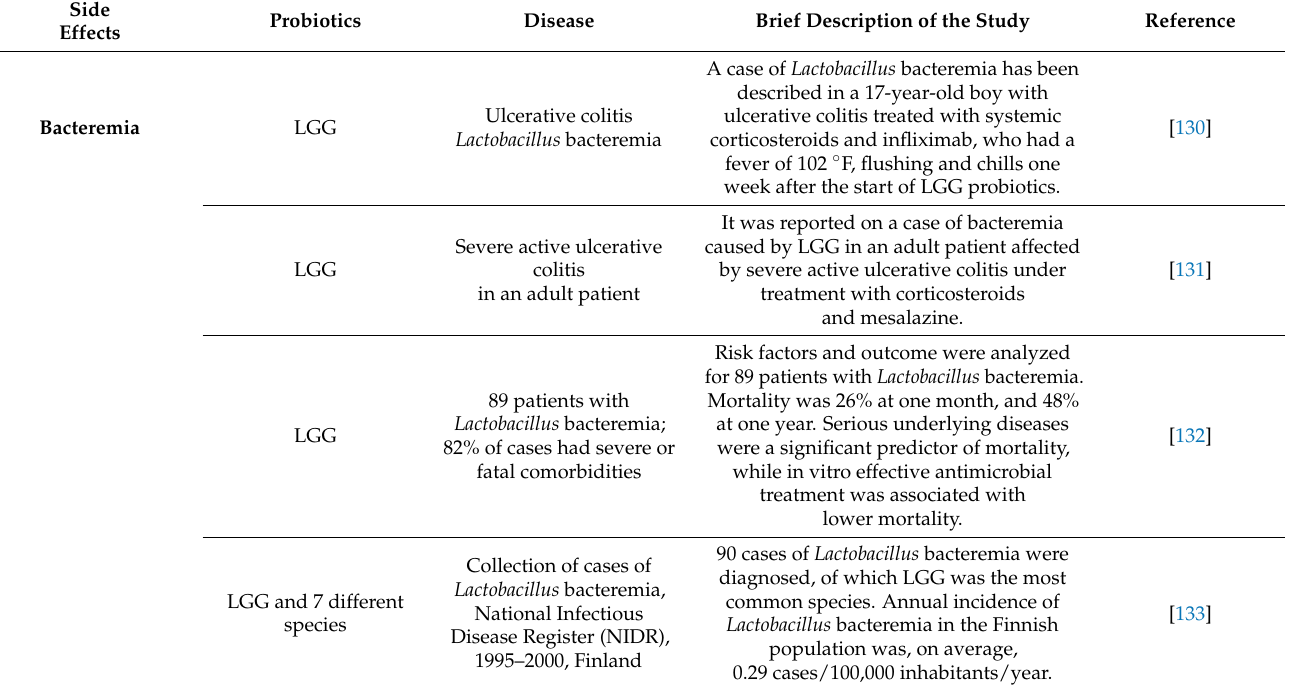
Table 3. Side effects of probiotics